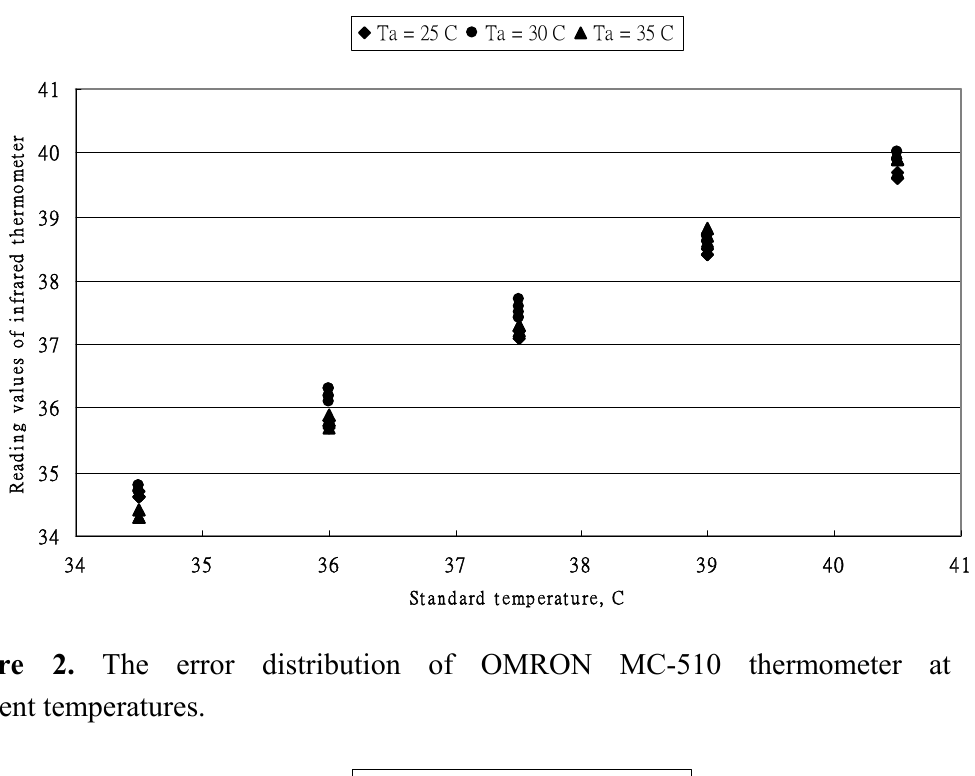
Figure 1. The relationship between reading values of MC-510 thermometer versus standard values.